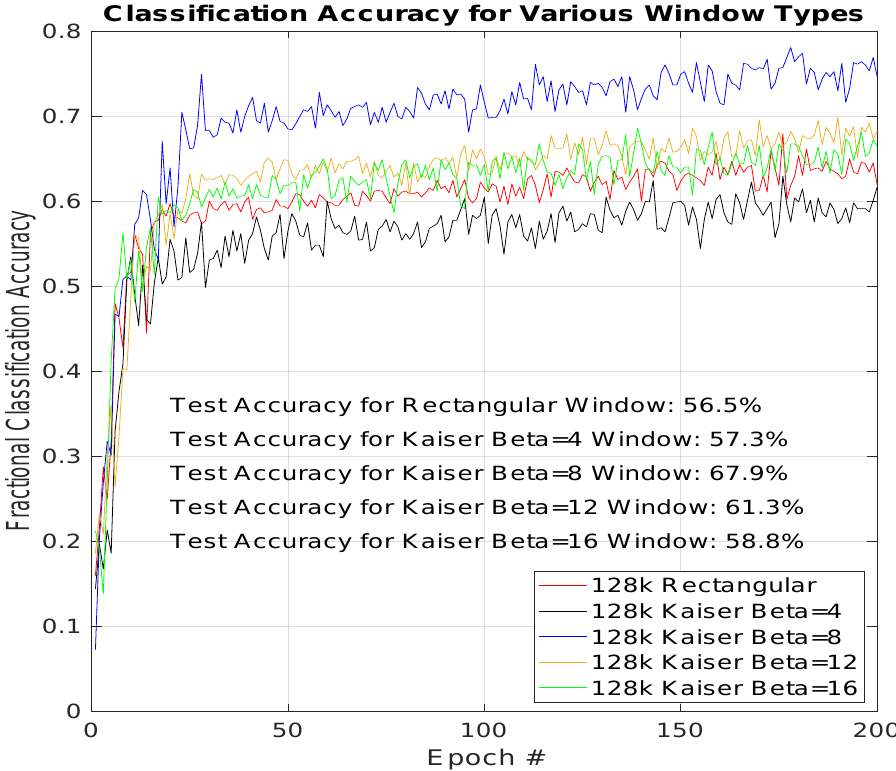
Figure 6. Classification accuracy vs. training epoch for various FFT window types with 10 × noise added.